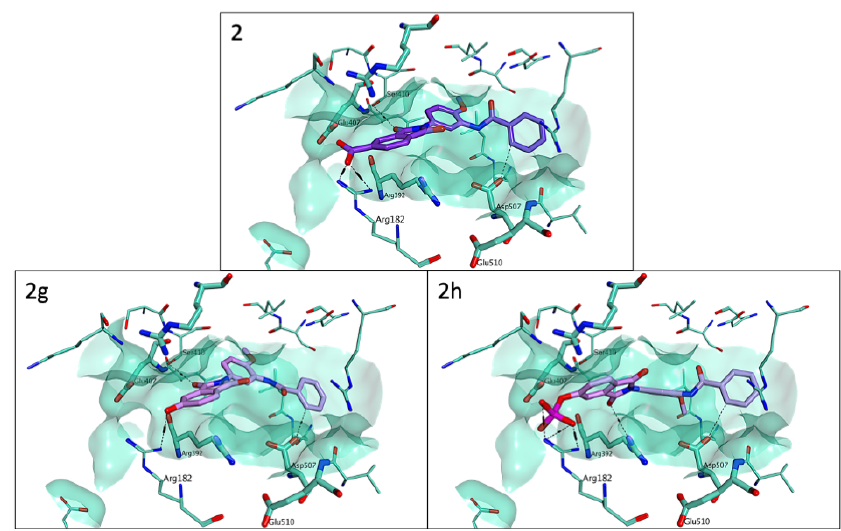
Figure 5. Proposed binding mode for 1 (carbon atoms in purple) and 1e , f (carbon atoms in lilac) to the human norovirus RdRp (PDB ID 4LQ3). The binding site area is represented as green molecular surface. Human norovirus RdRp is represented as green ribbon, with carbon atoms in green. Black dashed lines represent non-bonded interactions (e.g., hydrogen bonds, electrostatic interactions) be- tween the ligand and the amino acid residues of the protein. Figure 6 summarizes the predicted binding of the scaffold of 2 to HuNoV RdRp.